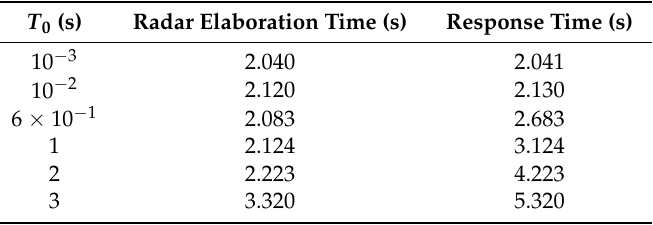
Table 8. Radar elaboration time and response time.